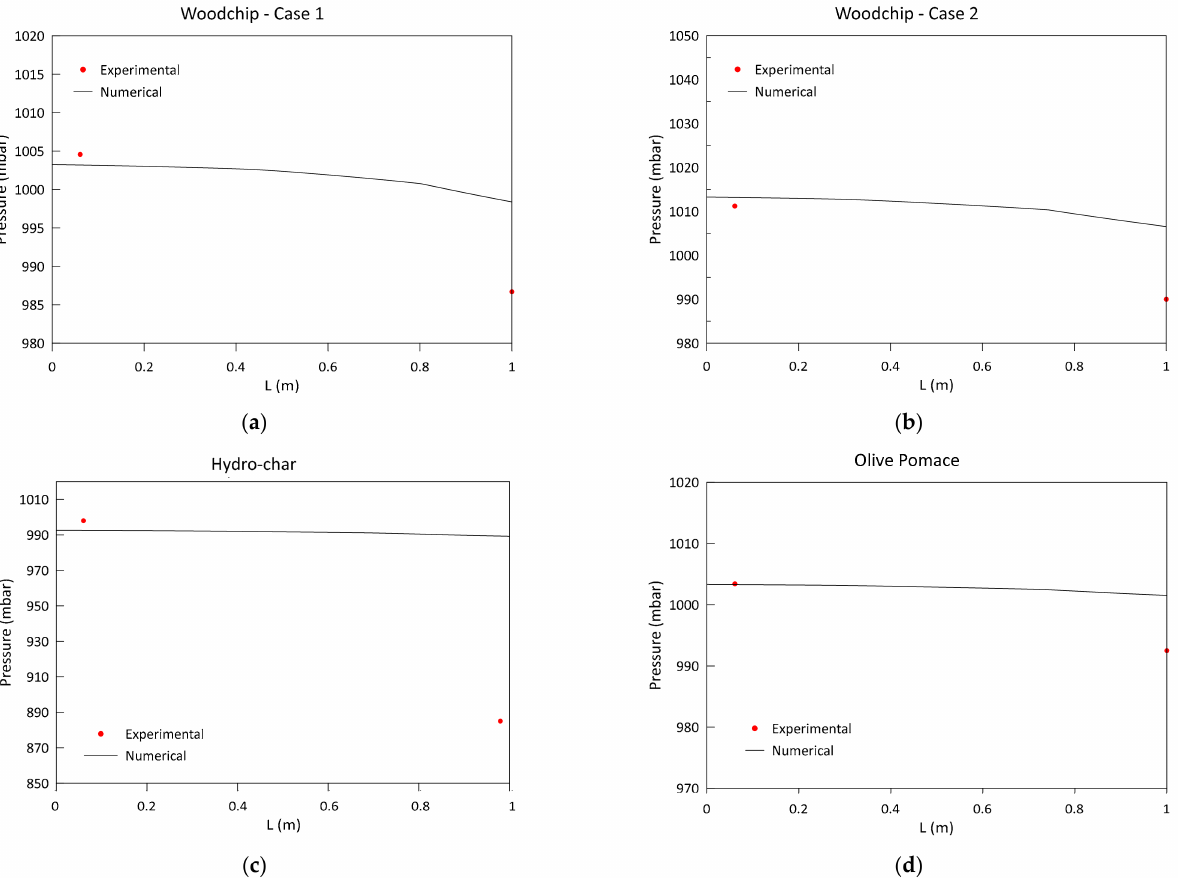
Figure 5. Comparison between the experimental measurements and the numerical pressure profiles for the four biomasses tested: ( a ) woodchip case 1, ( b ) woodchip case 2, ( c ) hydro-char from green waste, ( d ) olive